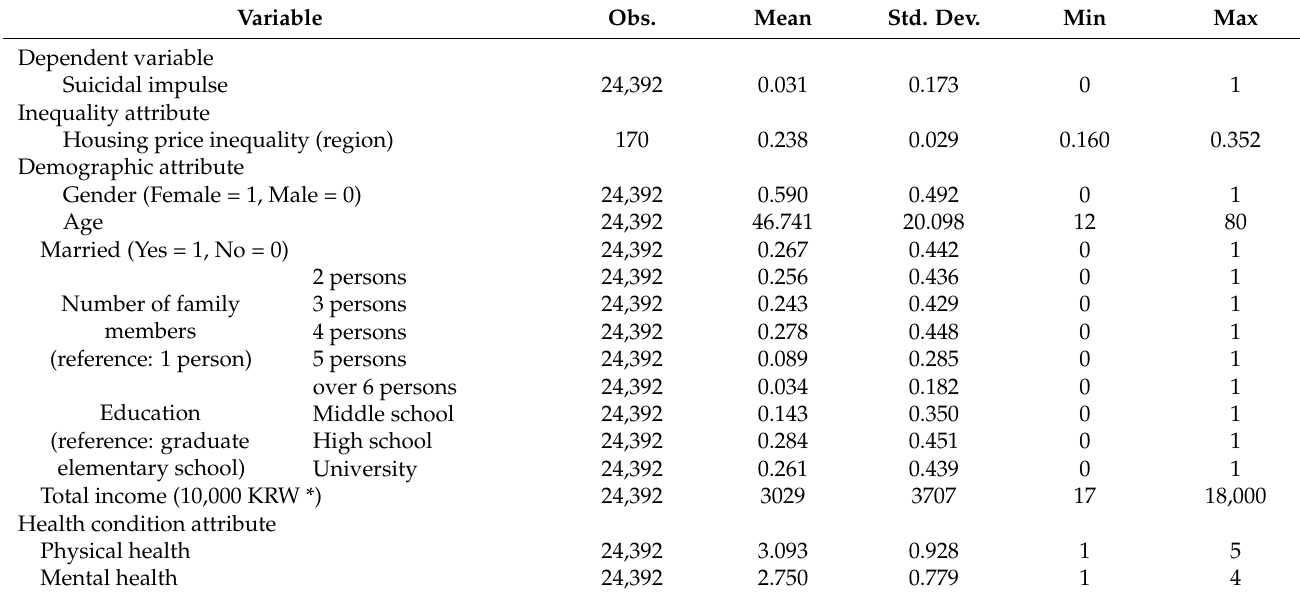
Table 1. Summary of